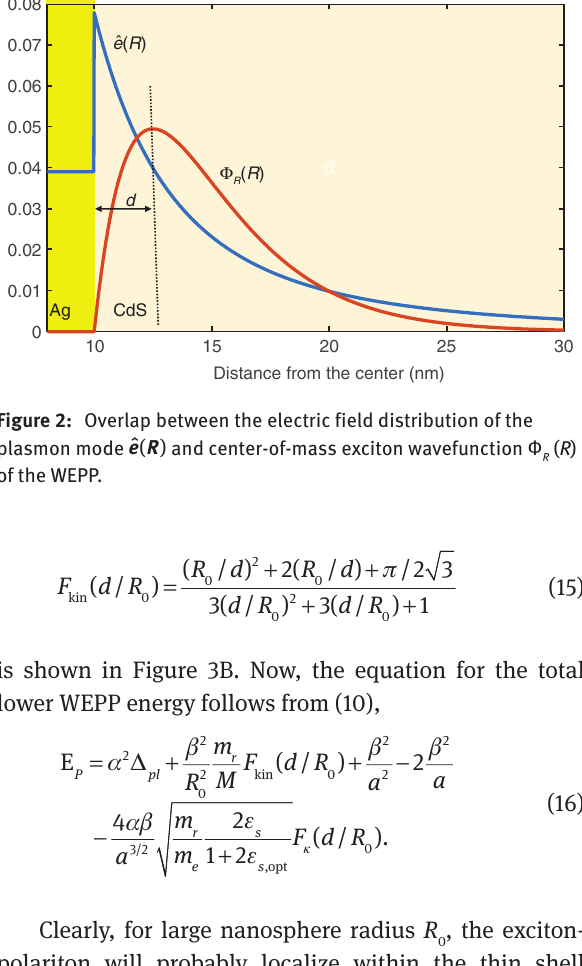
on relative thickness kin